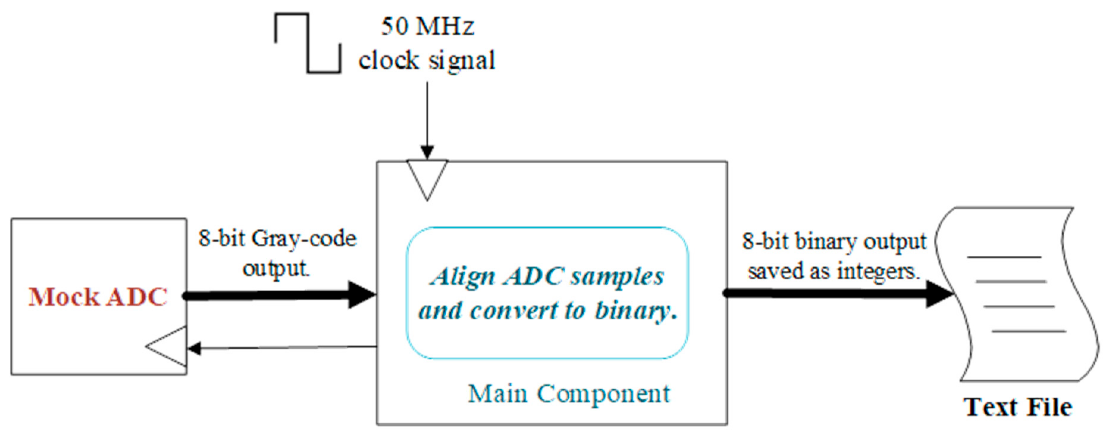
Figure 8. Testing the ADC output without applying the compensation algorithm.